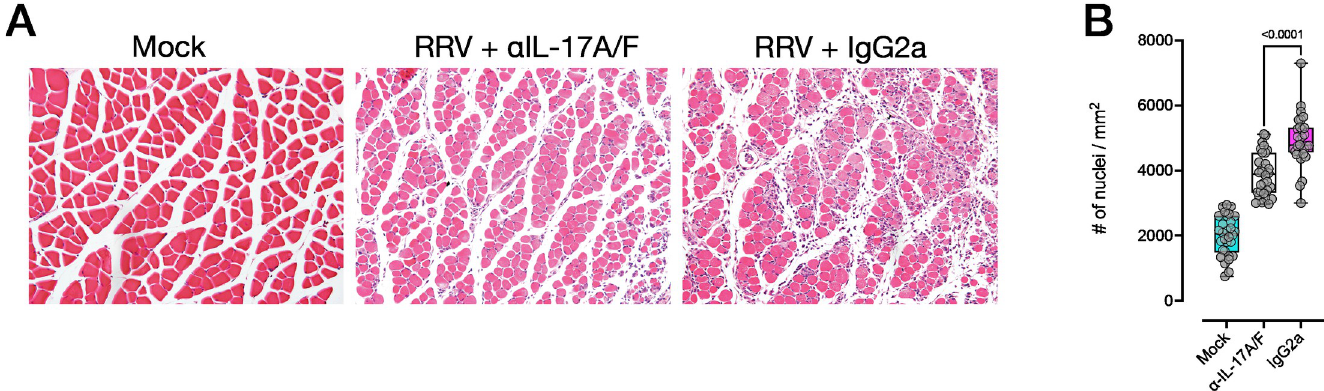
Fig 8. Anti-IL-17A/F monoclonal antibody reduces muscle inflammation in RRV infection. A) Hematoxylin and eosin (H&E) staining of paraffin sections of quadriceps muscle tissue of mock-infected, RRV-infected mice and RRV-infected C57BL/6J mice treated with anti-IL-17A/F mAb, at 10 dpi (20X objective). B) Quantification of cellular infiltrates (automated nuclei count) of H&E–stained muscle, as described in A) . Data are presented as the mean +/- SEM of 30 regions of interest (ROIs) per group. All data representative of n = 5 mice per group, NE = 2. Statistically significant differences between groups were determined with Mann- Whitney U test, p values indicated on